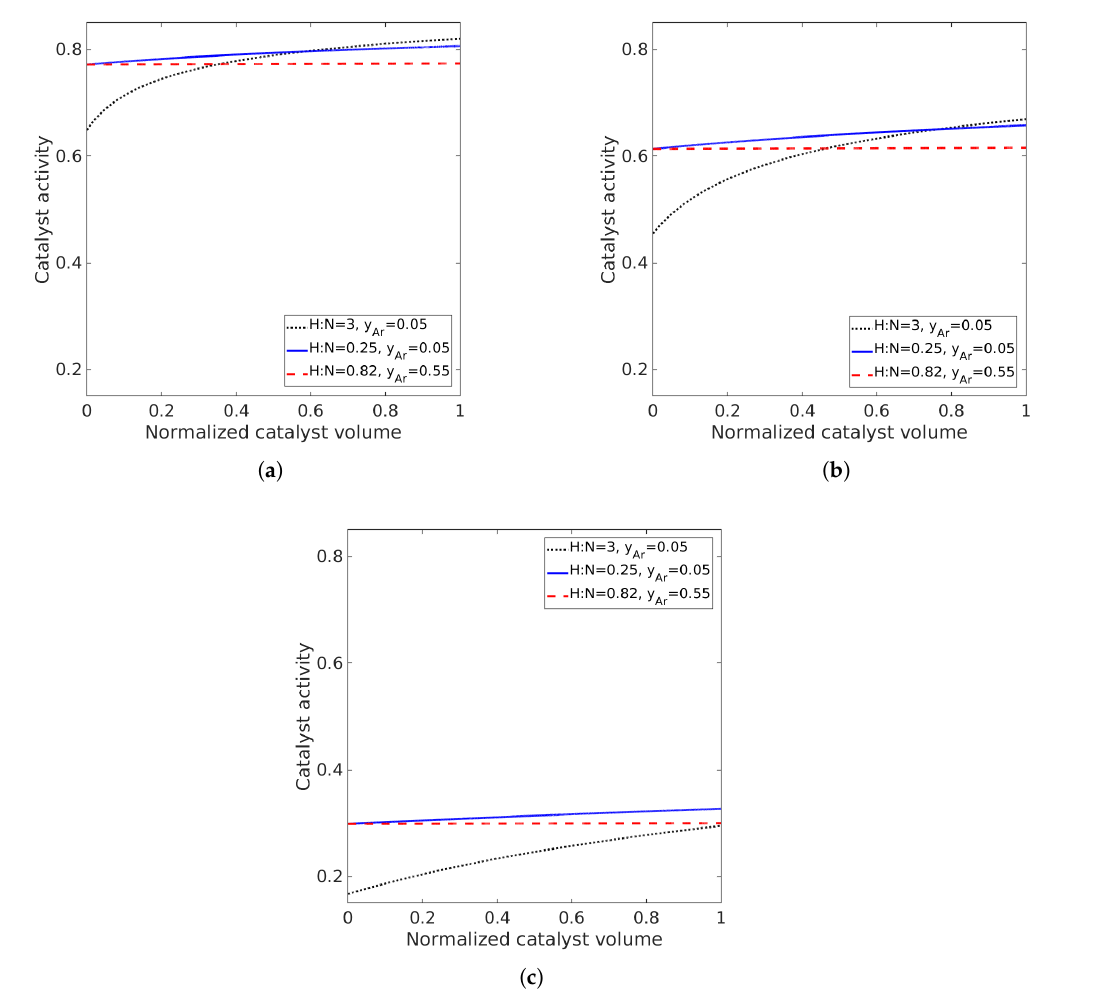
Figure 7. Change of catalyst activity along the catalyst bed for different gas compositions. ( a ) 5 ppm water; ( b ) 10 ppm water; ( c ) 30 ppm